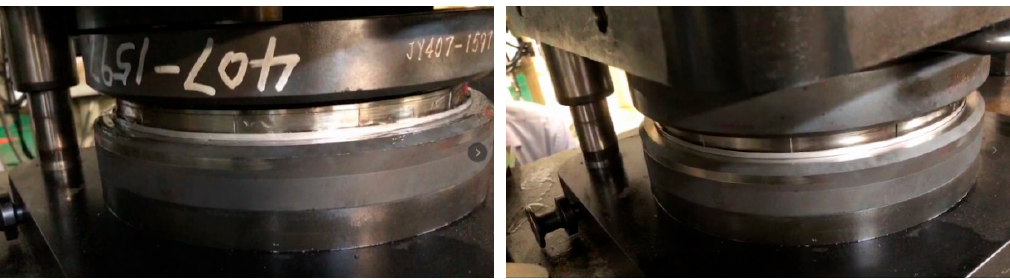
Figure 12. The experimental process of the first pass and the second pass.